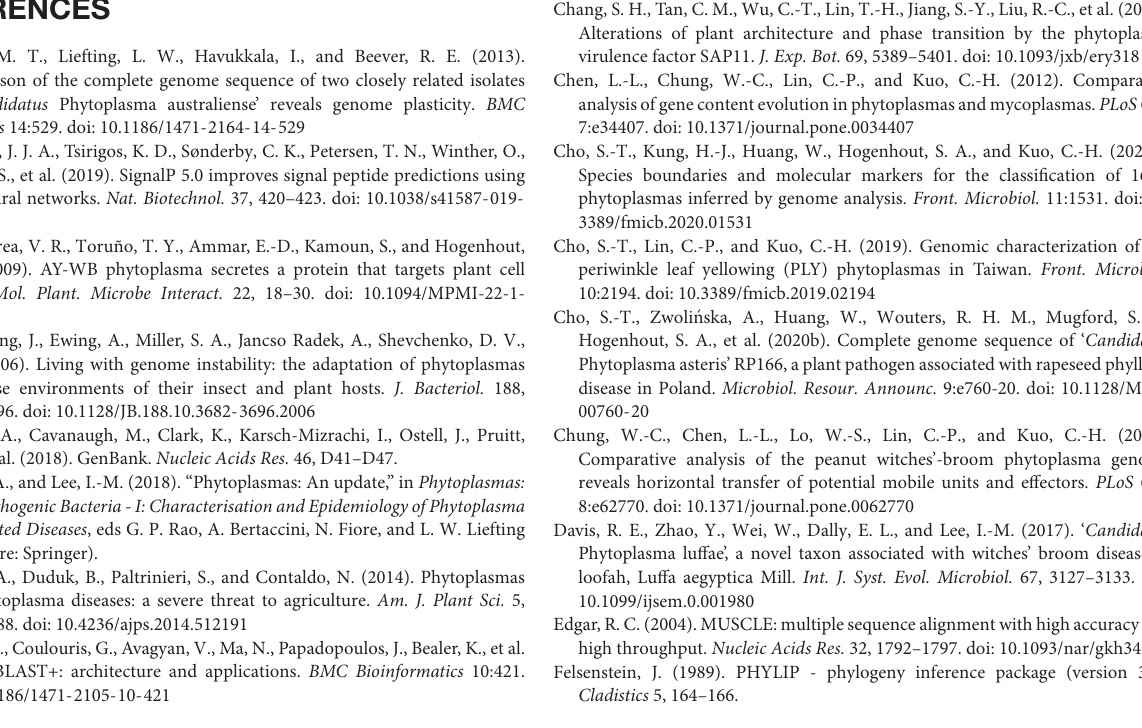
Supplementary Figure 1 | Coverage pattern of raw read mapping results to the genome assembly. Rings from outside in: (1) Scale marks (kb). (2) Sequencing depth calculated from Illumina (dark blue; outward) and ONT (light blue; inward) raw reads mapped to the assembly using a sliding window of 200-bp. A filtering step was applied to include only the reads with high alignment scores. For Illumina reads, the cutoff was set at 200, which identified 120,804 reads corresponding to an average sequencing depth of 47-fold. For ONT reads, the cutoff was set at 1,000, which identified 10,562 reads corresponding to an average sequencing depth of 79-fold. (3) Potential mobile unit (PMU) regions (orange). (4) Two duplicated chromosomal segments (green; positions: 316–391 and 391–467 kb). Supplementary Figure 2 | Genome size estimation based on k-mer analysis. (A) A representative frequency distribution of k-mer depth ( k = 21). The peak depth is 51. (B) Correspondence between genome size estimates and k-mer depths. Supplementary Figure 3 | Protein sequence alignments of four characterized phytoplasma effectors. Individual effectors are identified using locus tags. Shaded background colors indicate the levels of sequence conservation. (A) SAP05. (B) SAP11/SWP1. (C) SAP54/PHYL1. (D) TENGU. Supplementary Table 1 | List of potential mobile unit (PMU) core genes in the genome sequences analyzed. Supplementary Table 2 | List of potential mobile unit (PMU) regions among the genome sequences analyzed. One strain, ‘ Ca . P. asteris’ DY2014, was omitted because the PMU regions in this genome were reported to have complex structures and described in detail previously (Cho et al., 2019). Supplementary Data 1 | Concatenated multiple sequence alignment of conserved single copy-genes used for inferring the molecular phylogeny shown in Figure 3 . Simple text file in PHYLIP